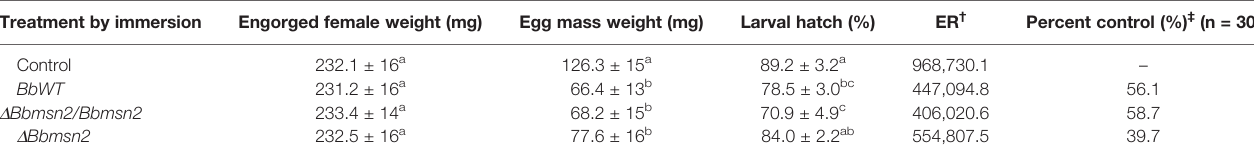
( † ) ER: estimated reproduction [ER = weight of egg mass (g)/initial weight of engorged female (g) × percentage of larval hatch × 20,000] (Drummond et al., 1971). ( ‡ ) Percent control [ER of the control group − mean ER of the treated group/mean ER of the control group × 100] (Drummond et al., 1971). Meansarefollowedbystandarderrorsof10replicatesperbioassay,inthreeindependent trials.Meansfollowedbythesameletterinthesamecolumndidnotdiffersigni fi cantly(P>0.05) according to the Student – Newman – Keuls (engorged female weight and egg mass weight) or Kruskal – Wallis test (larval